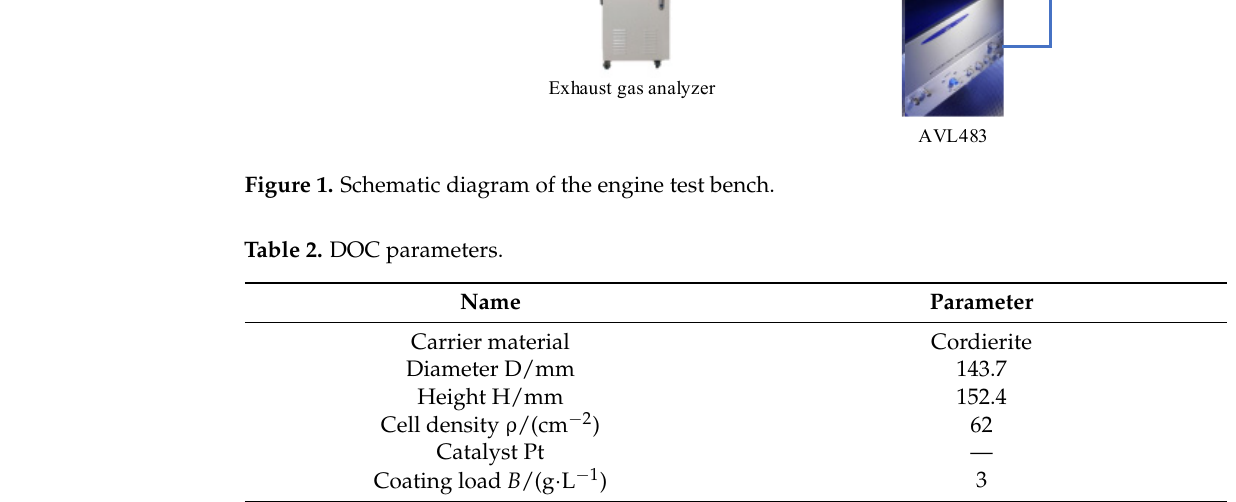
Z4 Figure 2. Temperature sampling points in DOC and DPF.